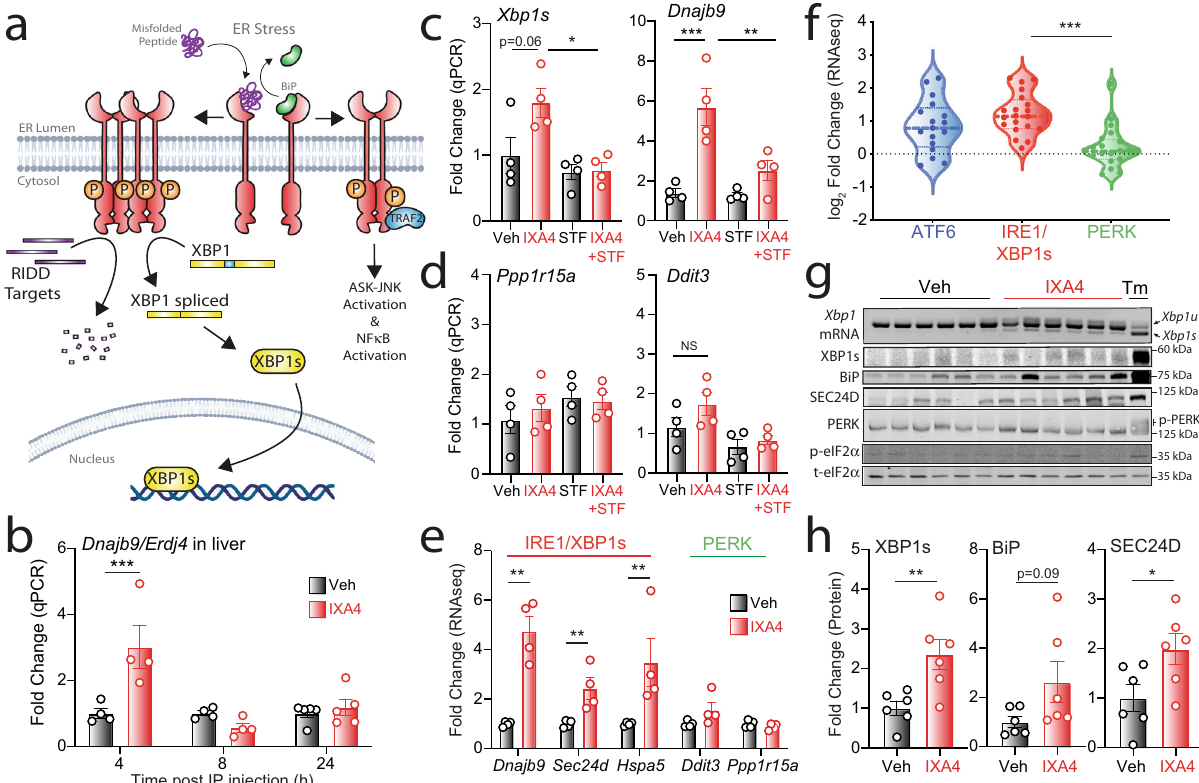
Fig. 1 IXA4 selectively induces protective IRE1/XBP1s signaling in the liver. a Schematic representation of the three downstream consequences of ER stress-induced IRE1 activation: XBP1s-dependent transcriptional signaling, RIDD-associated RNA degradation, and TRAF2-mediated ASK-JNK and NF- κ B signaling. b Expression, measured by RT-qPCR, of the IRE1 target gene Dnajb9 in the liver of chow-fed mice 4, 8, or 24 h after acute IXA4 intraperitoneal (IP) administration (50 mg/kg). Error bars show SEM for n = 4 or 5 mice. *** P < 0.001 for two-way ANOVA. c , d Expression, measured by RT-qPCR, of the IRE1-regulated genes Xbp1s and Dnajb9 ( c ) or the PERK-regulated genes Ppp1r15a and Ddit3 ( d ) in the liver of chow-fed mice 4 h after IP administration of IXA4 (50 mg/kg) and/or STF-083010 (STF; 10 mg/kg). Error bars show SEM for n = 4 mice. *** P < 0.001, ** P < 0.01, * P < 0.05 for one-way ANOVA. e Fold change in IRE1/XBP1s and PERK target genes, measured by RNA-seq (Supplementary Data 1), in the liver of DIO mice after 8 weeks of IXA4 (50 mg/ kg) treatment. Error bars show SEM for n = 4 mice. ** P < 0.01 for two-way ANOVA. f Fold change of ATF6, IRE1, and PERK target genesets 31 in the liver of DIO mice after 8 weeks of IXA4 treatment assessed by RNA-seq. Data are shown normalized to vehicle. Speci fi c genes used in this analysis are identi fi ed in Supplementary Data 2. *** P < 0.001 for one-way ANOVA. g , h Xbp1 mRNA gel (top) and immunoblots of UPR-regulated proteins in the liver of DIO mice after 8 weeks of IXA4 (50 mg/kg) treatment ( g ). Liver from mice treated for 16 h with tunicamycin (Tm; 1 mg/kg IP administered) is shown as a control. Quanti fi cation of XBP1s, BiP, and SEC24D in these immunoblots is shown in ( h ). Error bars show SEM for n = 6 mice. ** P < 0.01, * P < 0.05 for a two-tailed unpaired t test. Source data for all panels in this fi gure are provided as Source Data File 1. Uncropped images of the immunoblots in panel ( g ) are included in Source